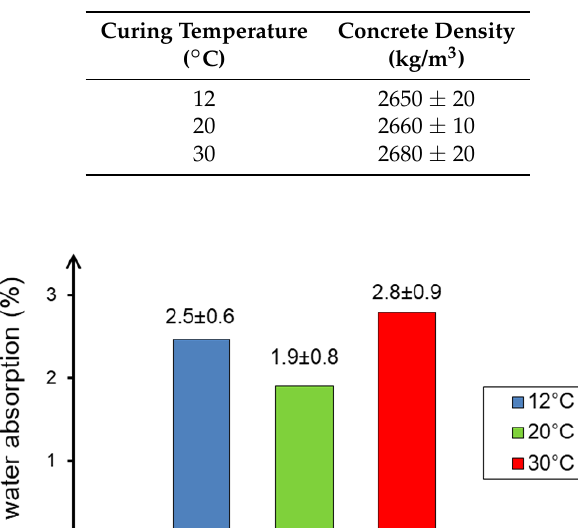
Table 6. Influence of ambient temperature on the density of concrete samples.